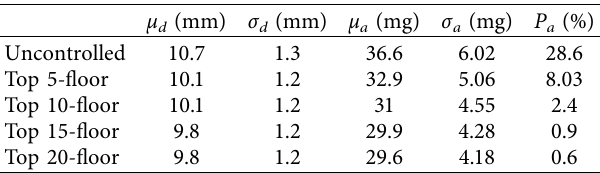
Figure 13: Distribution of maximum absolute responses under various vertical TLWD arrangements: (a) interstory drift ratio and (b) acceleration, with the dashed vertical line showing the performance threshold. Table 12: Performance of TLWD2 under various vertical